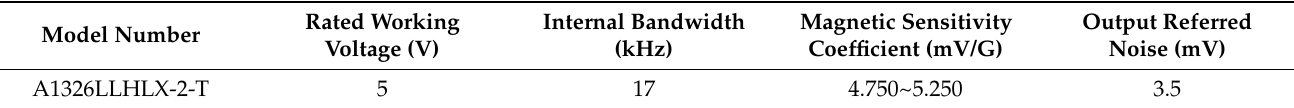
Table 2. The main characteristic parameters of the linear Hall